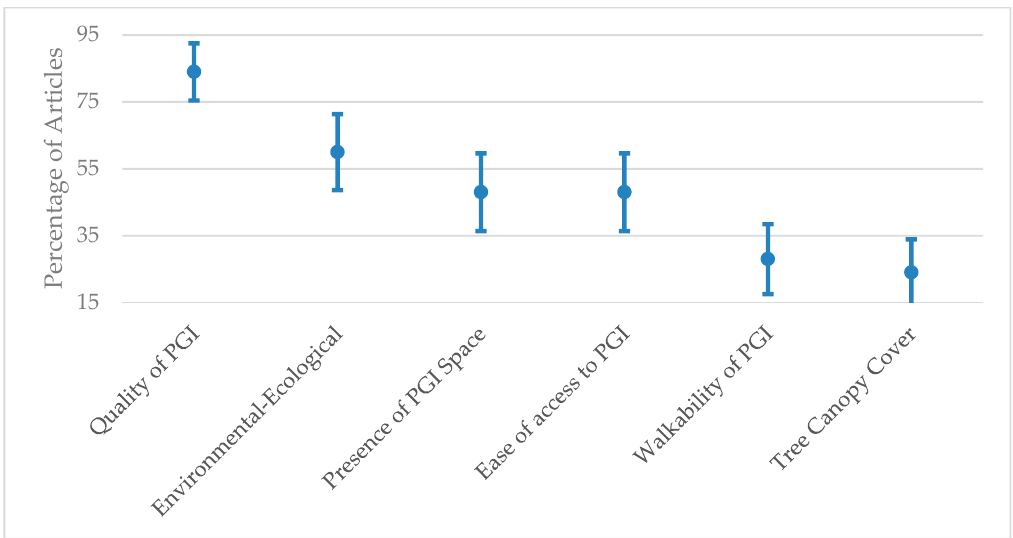
Figure 10. Rate of reporting (± 95% CIs of the proportions) regarding the attributes of PGI identified by this review as contributing to urban livability (n = 50). Percentages add to greater than 100% as articles that report multiple attributes are reported in more than one category. Table 6. Correlations (lower left) between reporting of PGI attributes that contribute to urban livability and the p-values for significance of the correlations (upper right). Significant correlations and the associated p-value are indicated by an